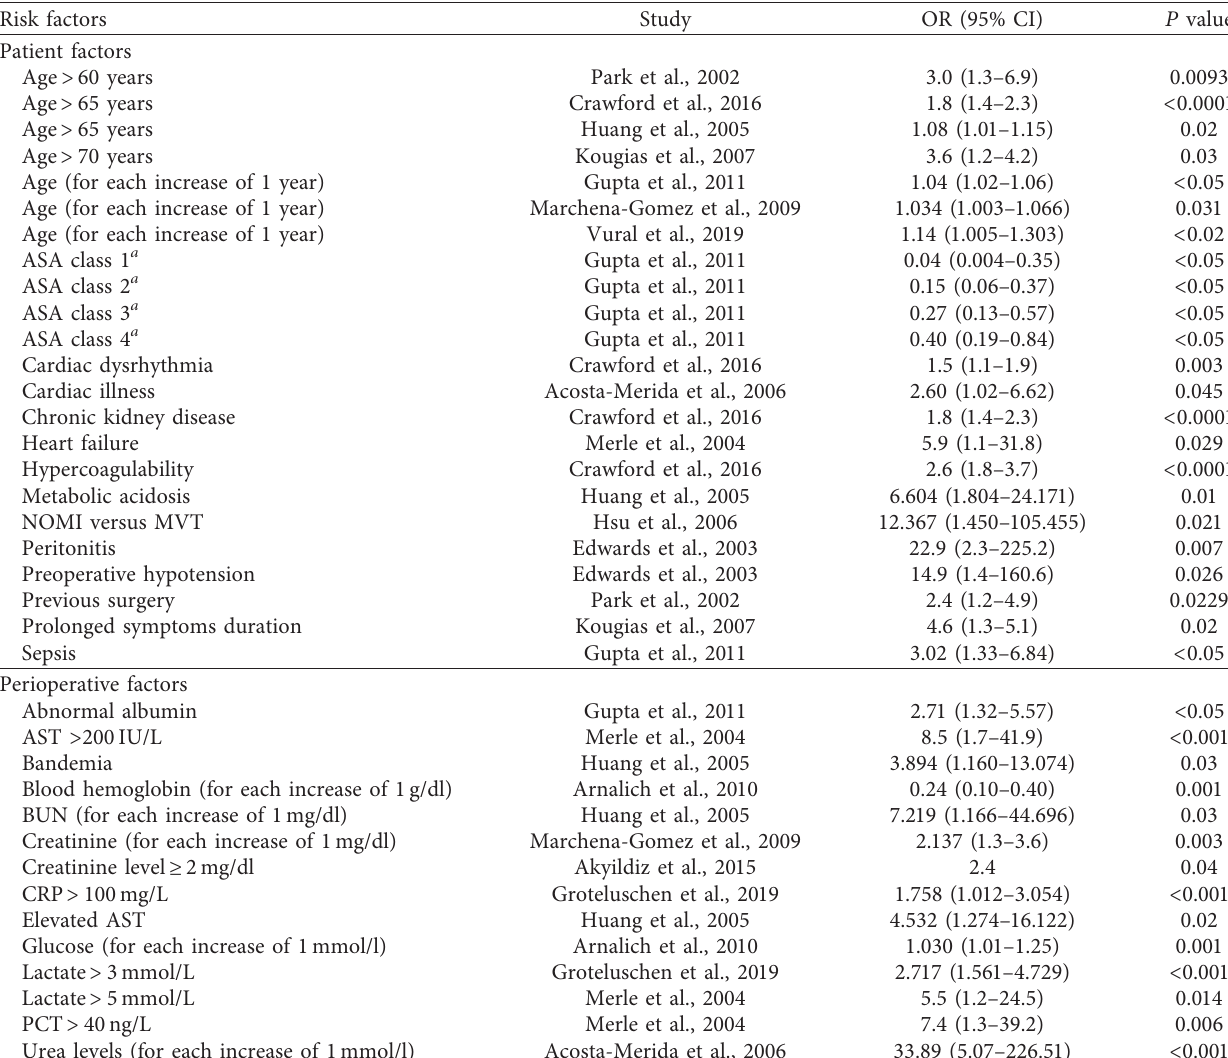
Table 3: Summary of risk factors analyzed in multivariate